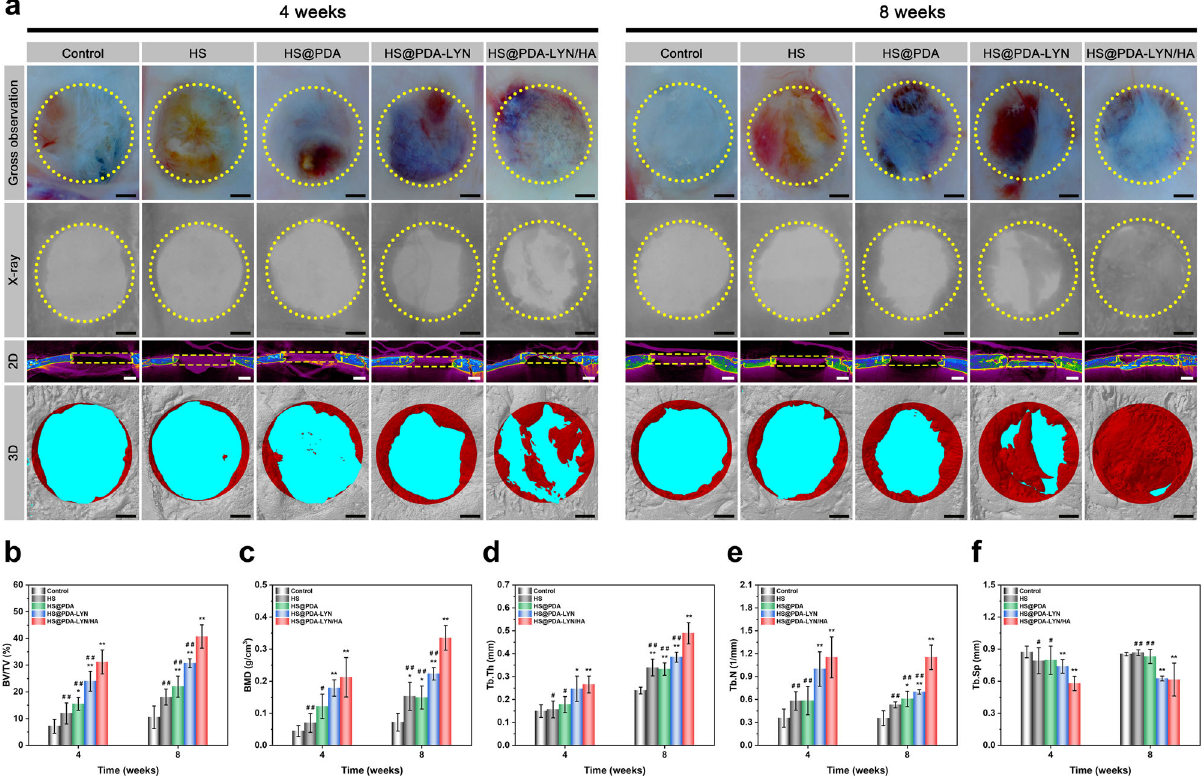
Fig. 8 Radiological analysis of bone formation in vivo. a Representative macrophotographs, X-ray, and micro-CT images of the calvarial defect at 4 and 8 weeks after implantation. The yellow dotted lines indicate the initial boundary of critical-sized cranial defects. The red zones indicate the newly formed bone tissue in the defect areas. Summarized data of b BV/TV, c BMD, d Tb.Th, e Tb.N, and f Tb.Sp of the calvarial defect area. Scale bar in a : 1 mm. Data are expressed as the mean ± SD ( n = 4). * P < 0.05 and ** P < 0.01 indicate signi fi cant differences compared with the control group. # P < 0.05 and # # P < 0.01 indicate signi fi cant differences compared with the HS@PDA-LYN/HA